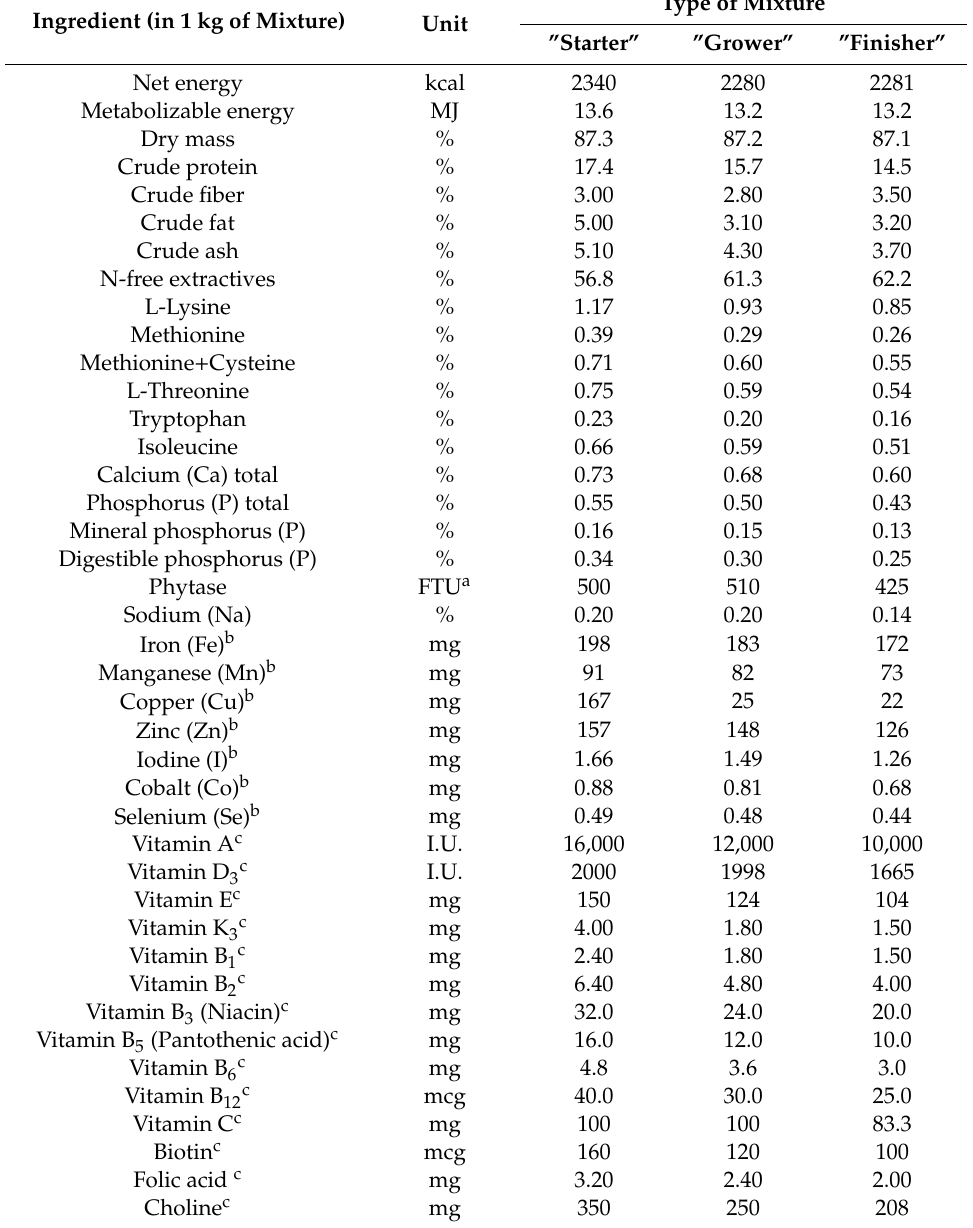
Table 1. The chemical composition of feed mixtures for growing pigs (Reproduced with permission from Saeid et al., J. Appl. Phycol.; published by Springer, 2013 [23]). Ingredient (in 1 kg of